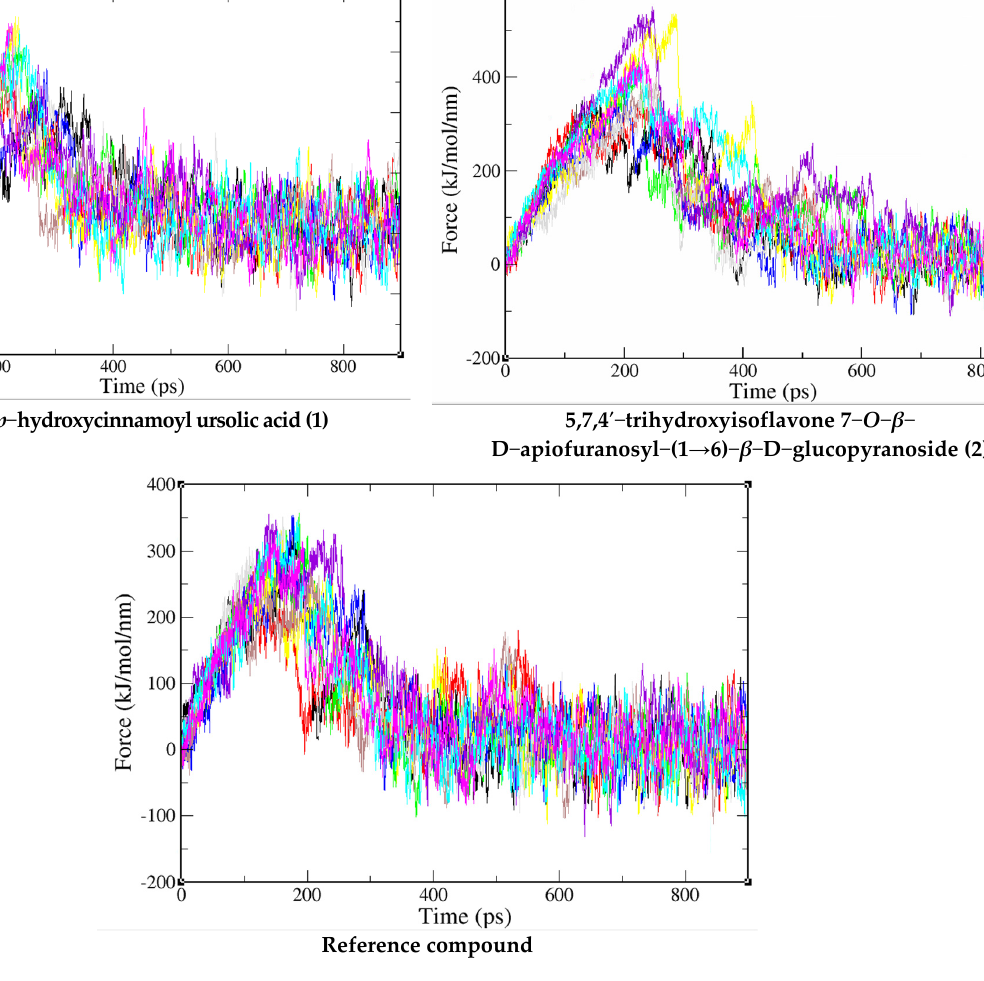
Table 3. Test results of in vitro cytotoxicity of crude extract, fractions, and compounds ( 1 and 2 ).